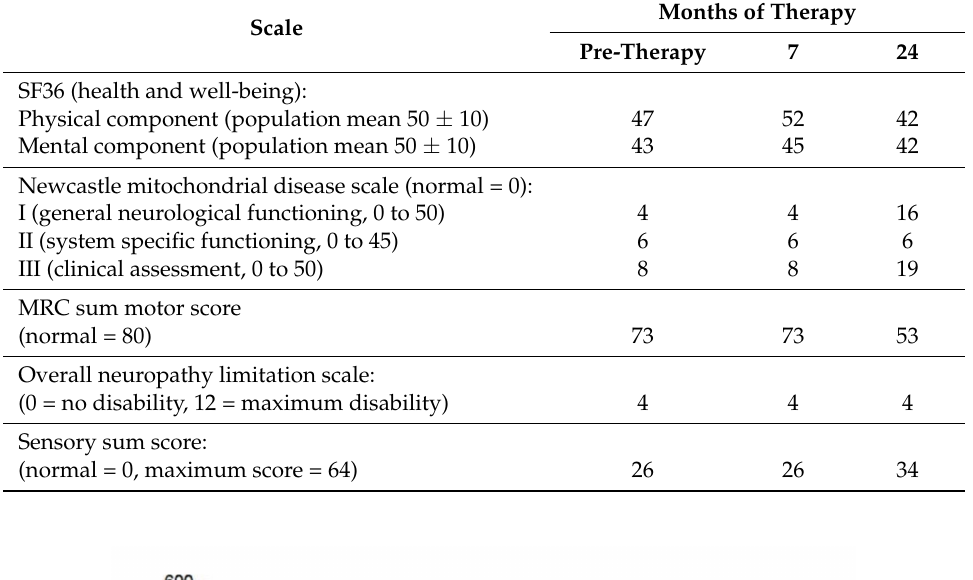
Table 3. Quality of Life and Disease scores for Patient 1, pre-therapy and during EE-TP therapy.